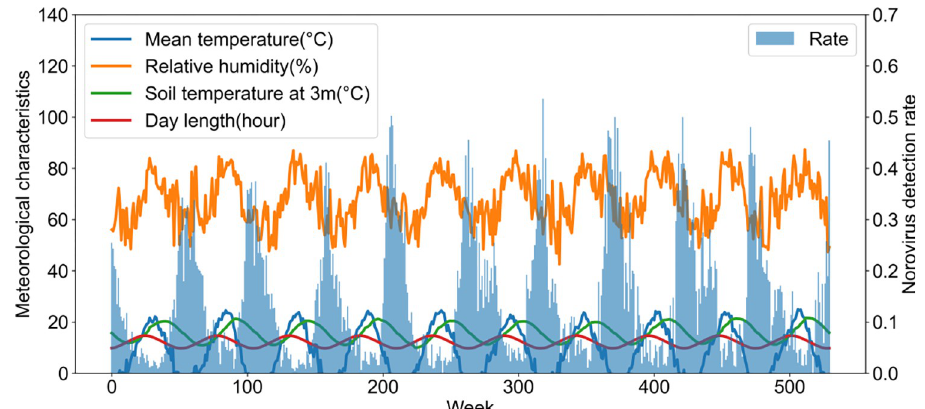
Fig 2. Weekly norovirus detection rate and meteorological characteristics curves (average of temperature, relative humidity, soil temperature at 3m, and day length) from 2009 to 2018 in South Korea.